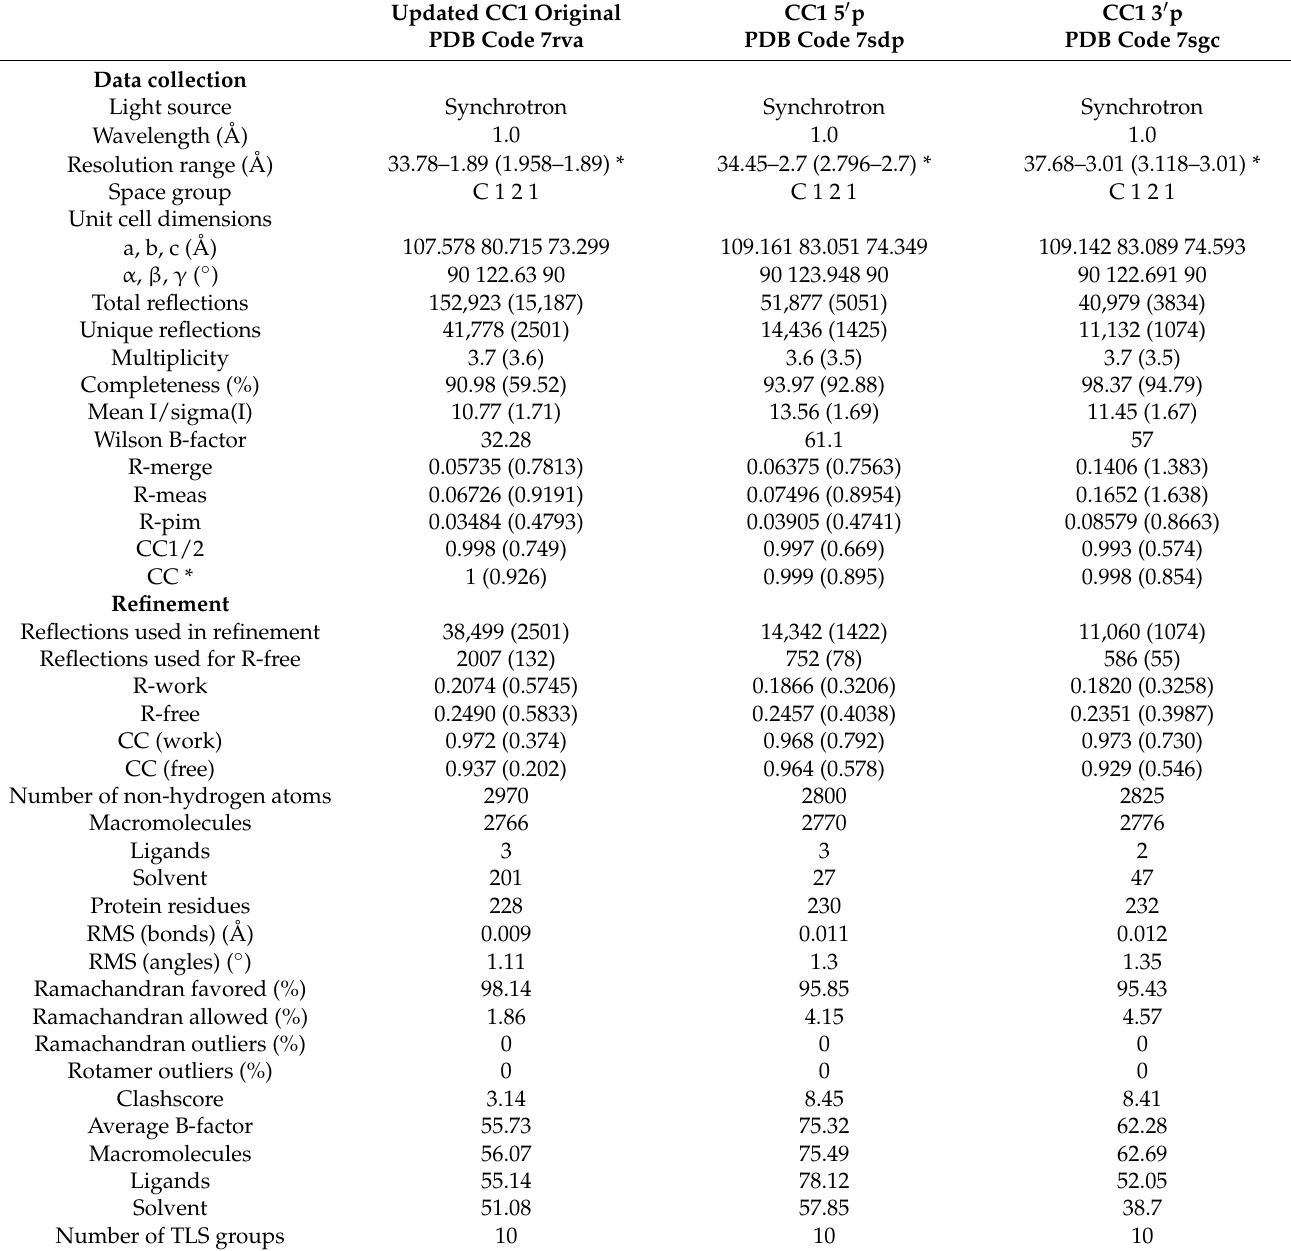
Table 1. X-ray diffraction statistics for the updated original CC1 crystal, the CC1 crystal with terminal 5 (cid:48) phosphates, and the CC1 crystal with terminal 3 (cid:48)